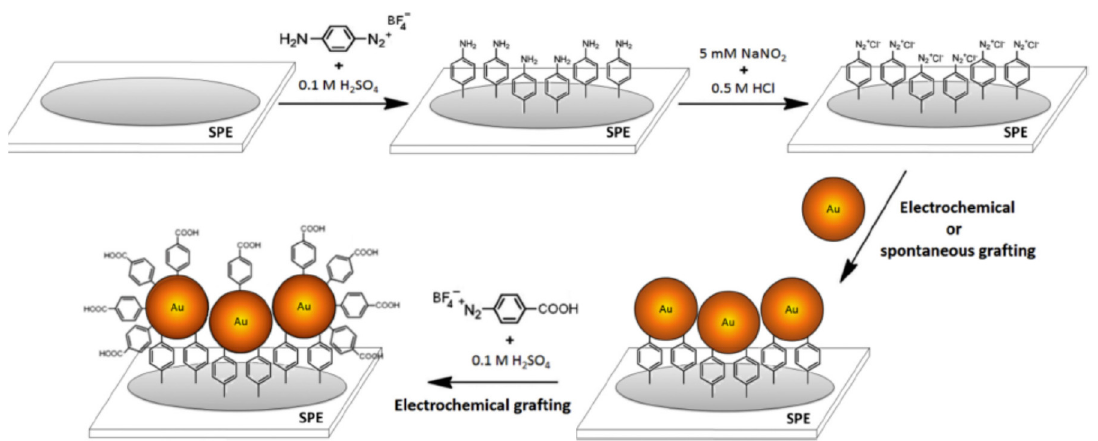
Figure 8. Gold nanoparticles covalently attached to a screen-printed electrode (SPE) and modified with caboxyphenyl groups for sensing metal ions. From Reference [49] with permission from Elsevier.